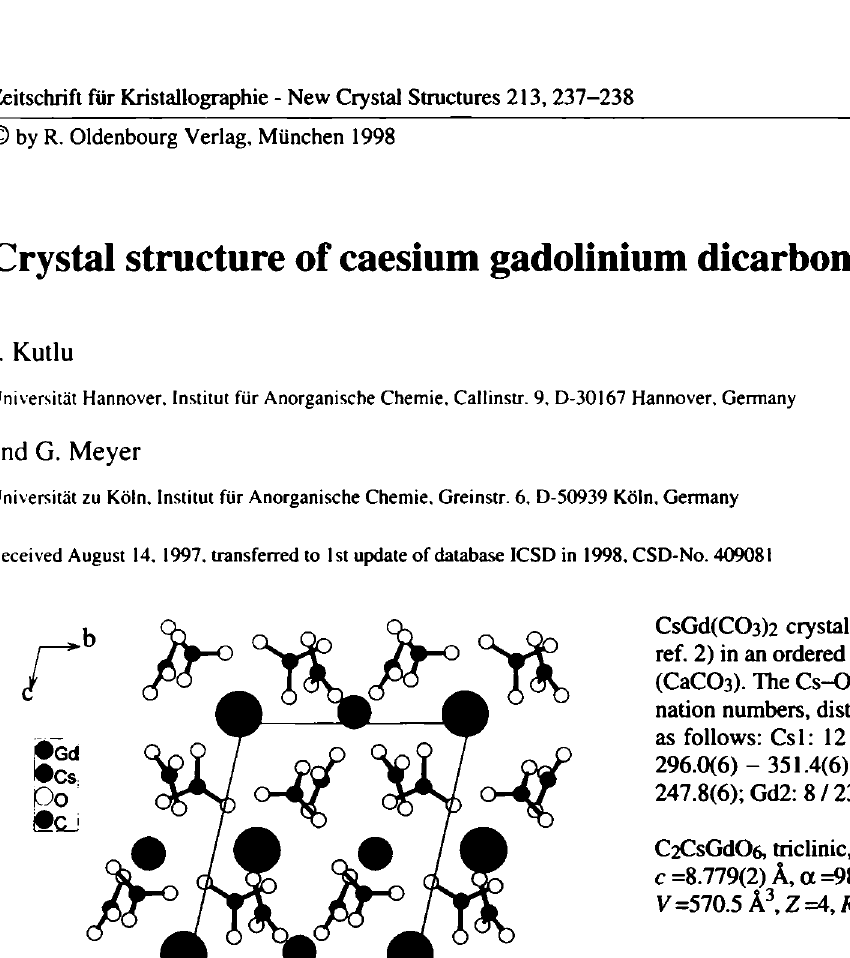
Table 1. Parameters used for the X-ray data collection